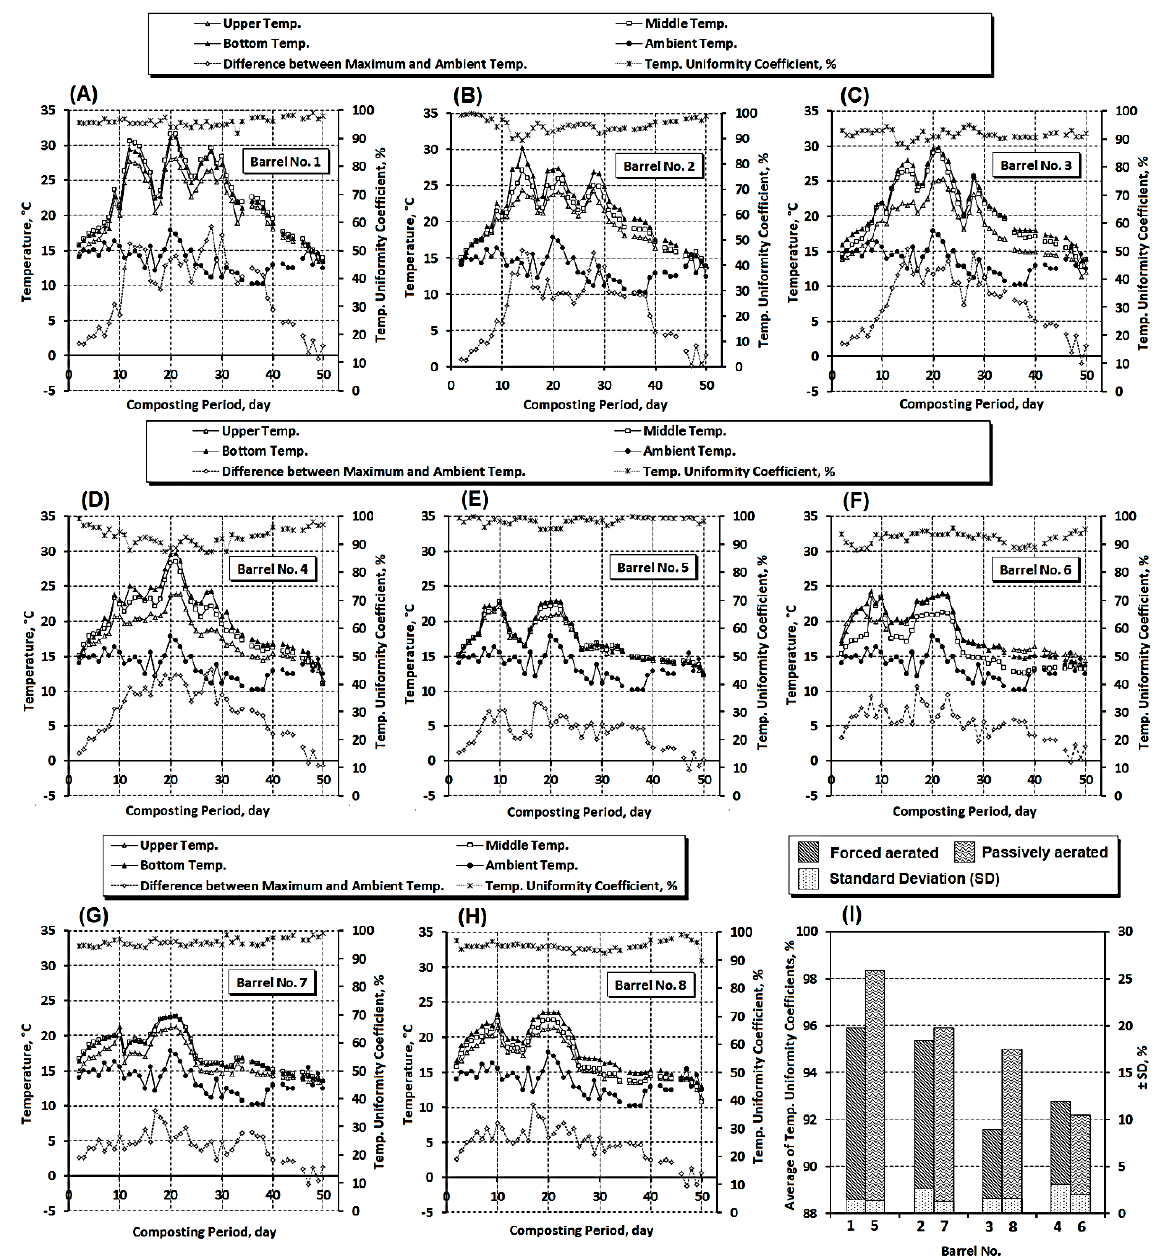
Figure 5. Temperature–time profile of each barrel measured at three various levels and temperature uniformity coefficients between them during composting period ( A – H ); Temperature uniformity coefficients averages for the whole period in each barrel where every two barrels contain the same composting mass were collected together for comparison ( I ).